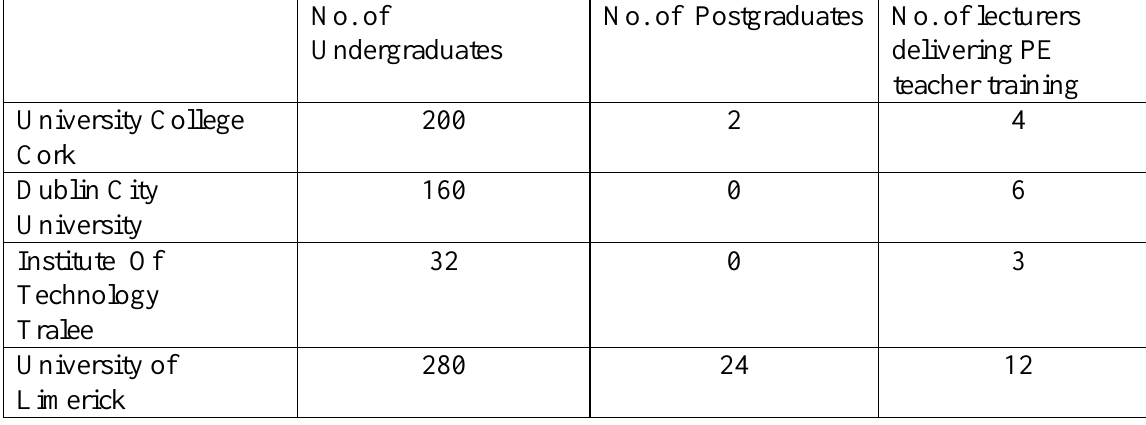
Table 1: Numbers of students and lecturers in Irish Institutions No.